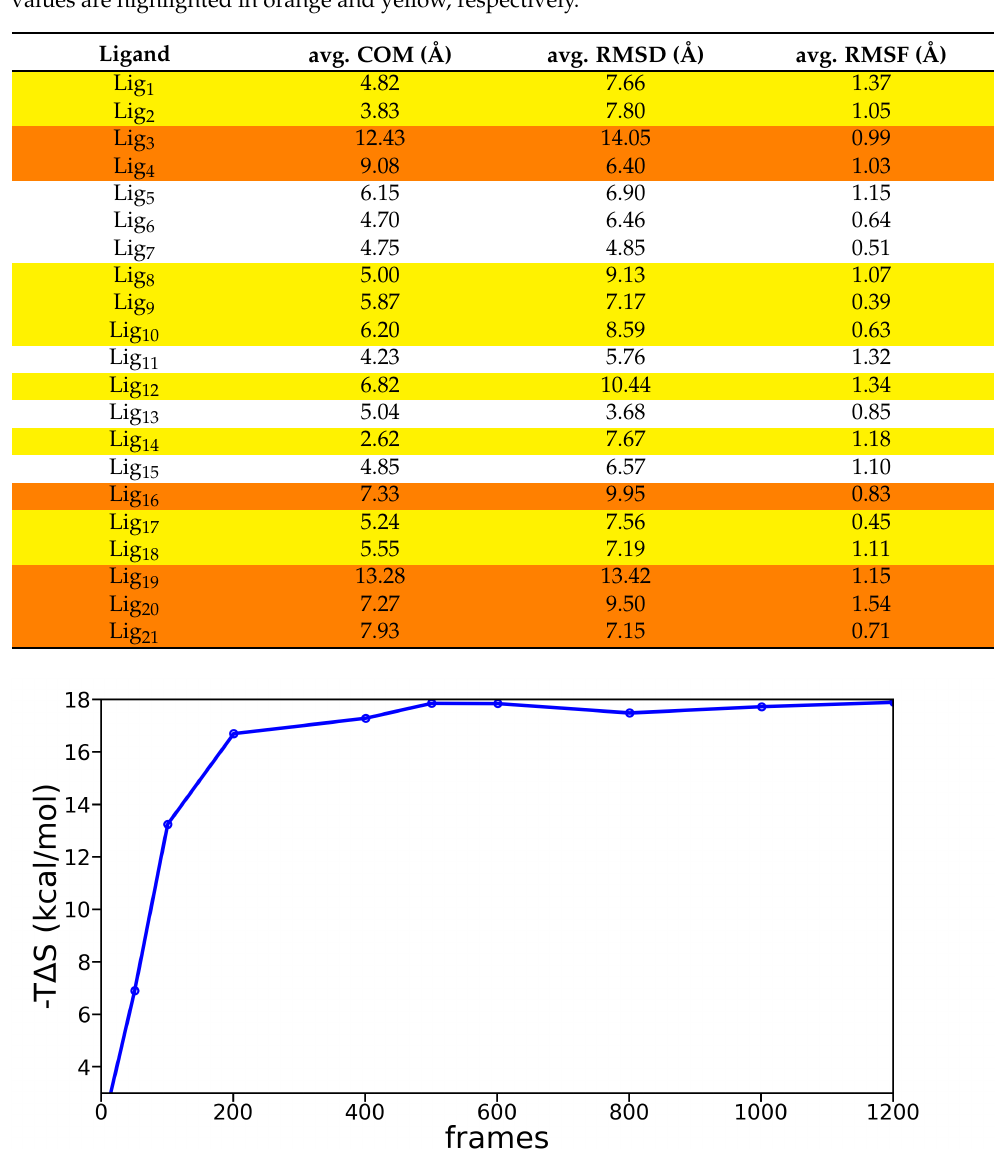
Figure A7. The difference in the entropic terms, T ∆ S , of the ligand Lig 9 , receptor, and Lig 9 -receptor complex simulations calculated based on the last 30 ns of the simulations and a varying number of equally spaced